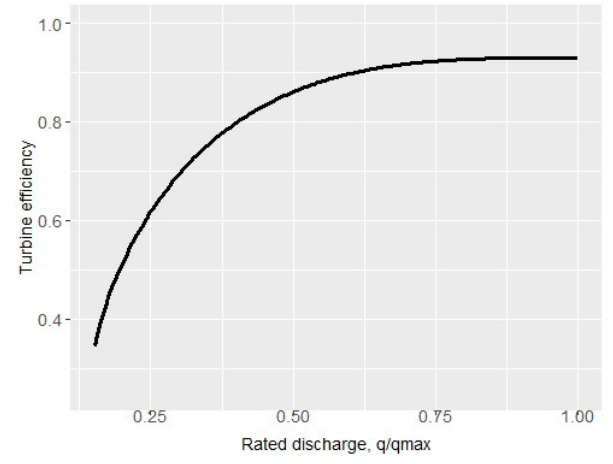
Figure 1. Efficiency curve for the Francis turbine applied in the hydropower system under study (analytically-derived relationship provided by Sakki et al., 2021, based on nomographs by Papantonis, 2008, p.